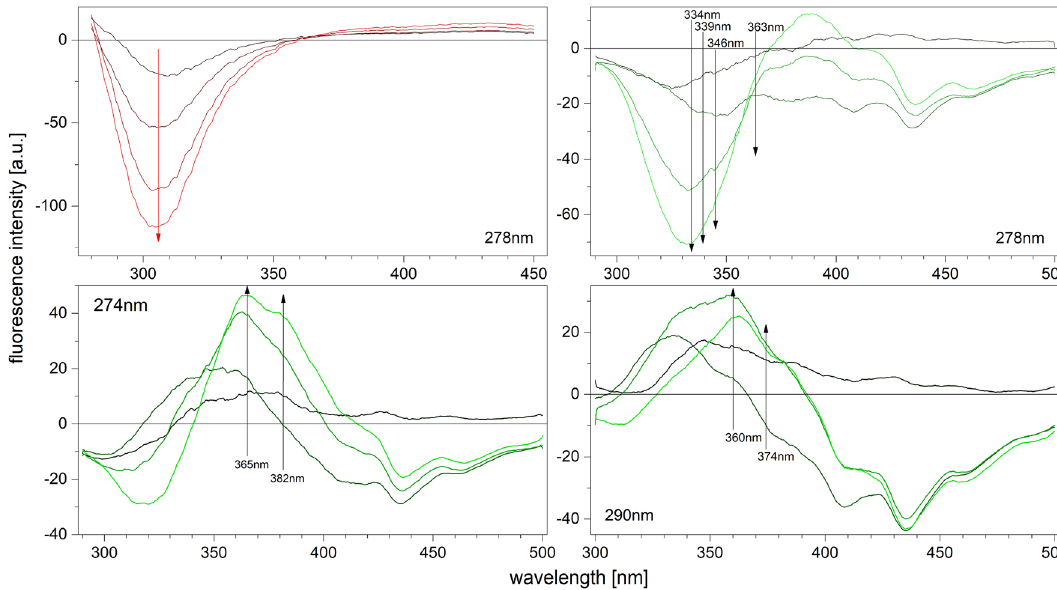
Figure 3. Differential fluorescence spectra of the E. coli PNP complexes with phosphate, left upper panel for the WT PNP (red), remaining graphs for the Y160W mutant (green), obtained at 25 °C, in 50 mM Tris/HCl buffer pH 7.6. The excitation wavelengths at which the spectra were measured are denoted on each graph. Phosphate concentrations were as follows: 10 μM, 100 μM, 1000 μM, 10 000 μM. The increase in phosphate concentration is marked with the gradient of the colour, black for the lowest, red (for the WT) or green (for the Y160W mutant) for the highest phosphate concentration. In the graphs for the Y160W mutant, the wavelengths chosen for the observation for each excitation wavelengths are marked by arrows. These data, together with the excitation wavelength shown on the graph, define conditions, in which titrations presented on Fig. 4, were performed. Direction of the arrows indicates only the direction of the phosphate concentration